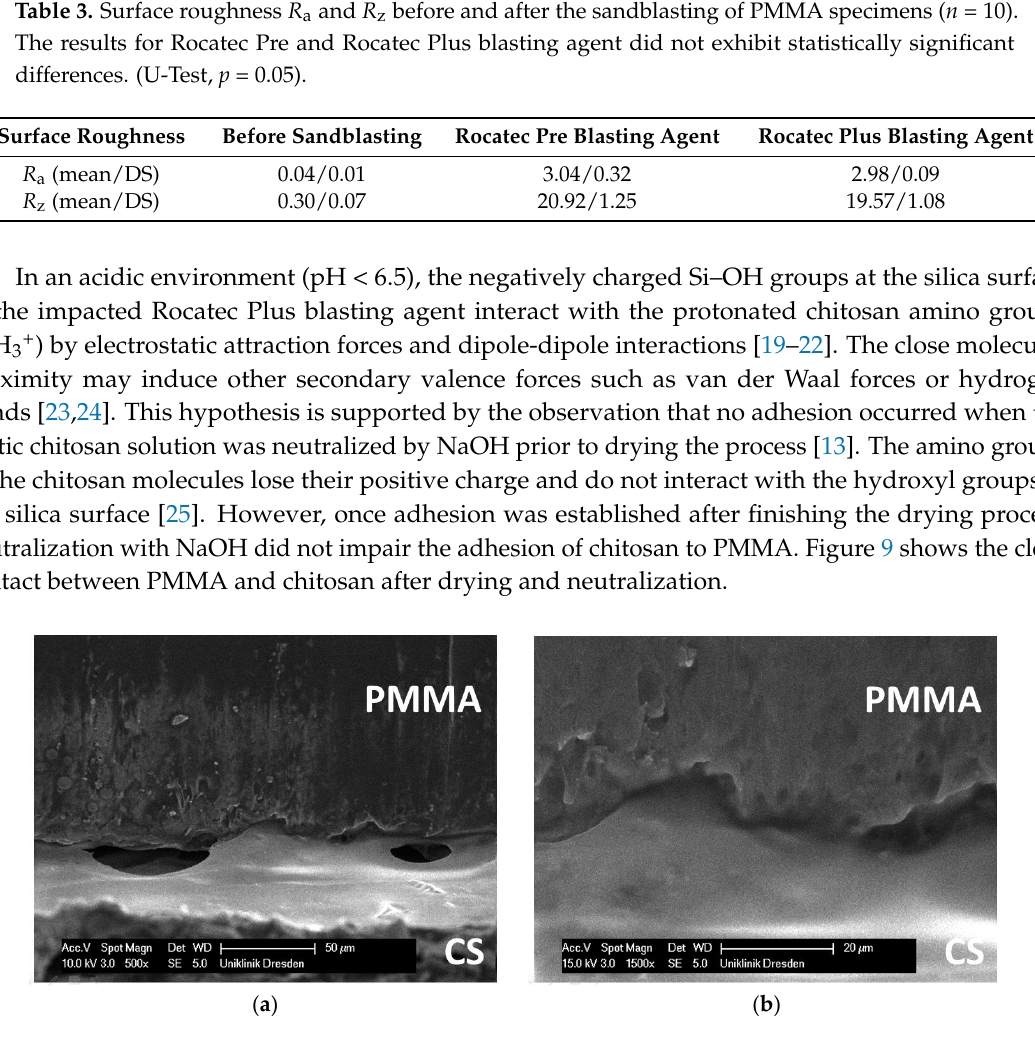
Figure 9. Scanning electron microscope images showing the morphology at the chitosan/PMMA interface after coating with 4% acetic chitosan solution ( a ). Despite its high viscosity, the adhering chitosan layer is in direct proximity to the sandblasted PMMA substructure following peaks and valleys of the surface roughness profile ( b ). The voids at the chitosan/PMMA interface are probably a result of moisture loss while evacuating the SEM chamber and heating by the electron beam.